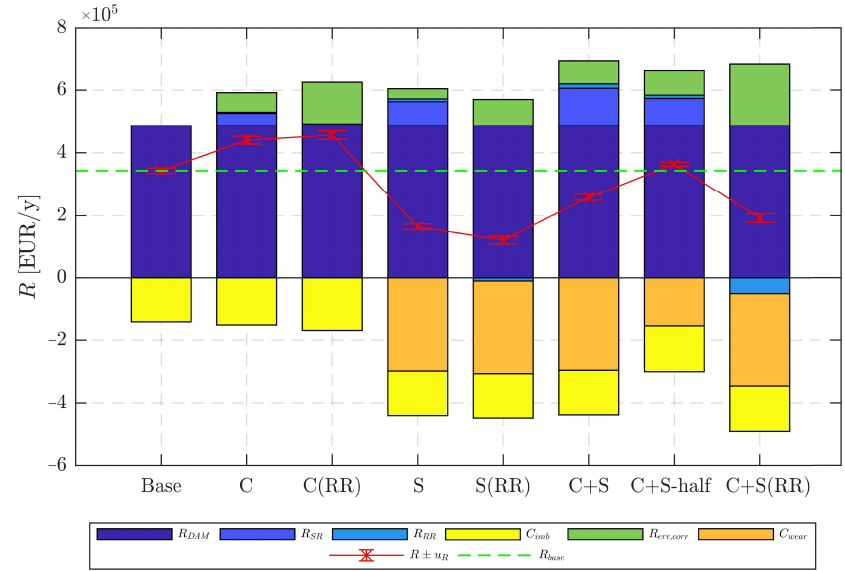
Figure 7. Economic results of the proposed EVU configurations.